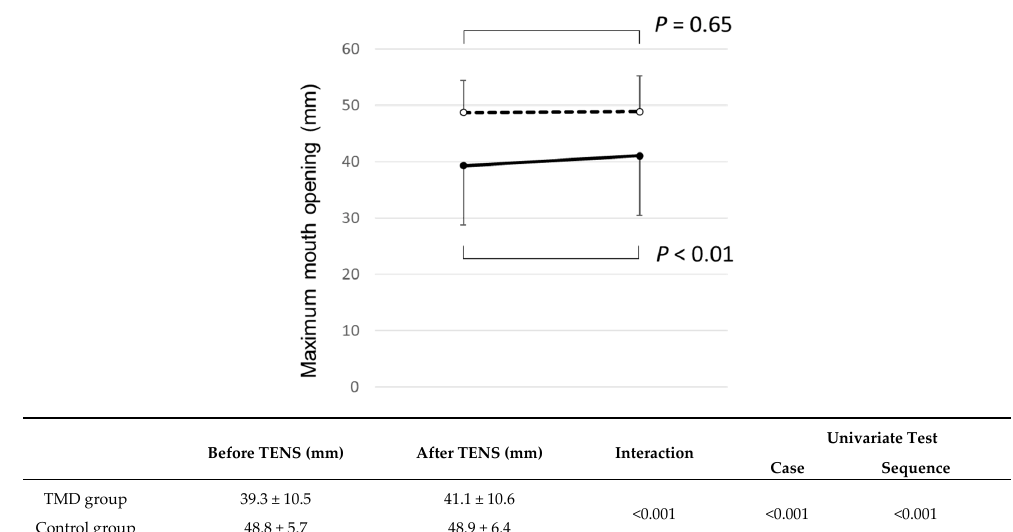
Figure 2. Changes in pain intensity before and after transcutaneous electrical nerve stimulation (TENS) treatment. Data are the Median (IQR: first quartile–third quartile). There was a significant decrease in the mean visual analog scale (VAS) value after the TENS treatment (Wilcoxon signed rank sum test).